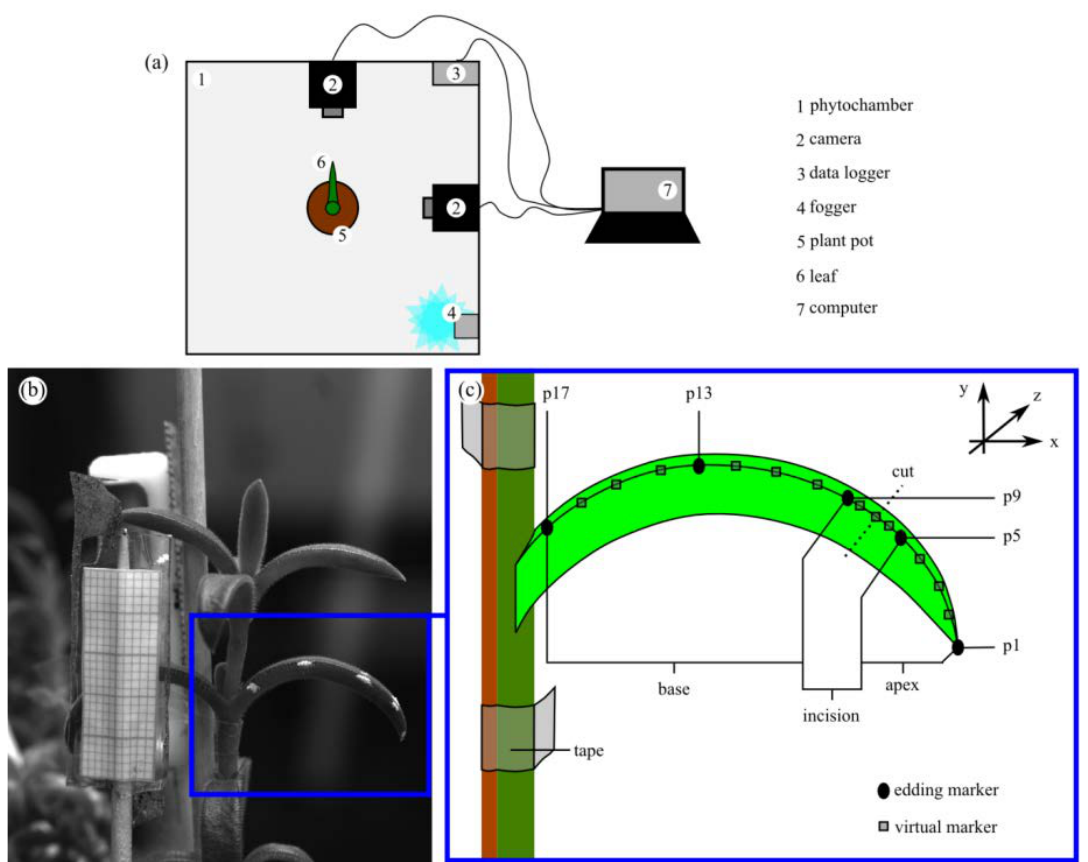
Figure 6. Video tracking of the self-sealing kinematics of D. ecklonis leaves. ( a ) Experimental setup within a temperature and relative humidity (RH) controlled custom-built phytochamber. ( b ) Image of a Delosperma leaf and sample mounting during an experiment. The stem is fixed to a bamboo stick by using tape. The white marker points indicate the apex (p1), the regions 2 mm above (p5) and below (p9) the incision (cut), the base (p17), and half the distance between points p9 and p17 (p13) of the leaf. ( c ) Schematic representation of the sample mounting and tracker placement along a leaf. The leaf segments “apex”, “incision” and “base” are indicated.